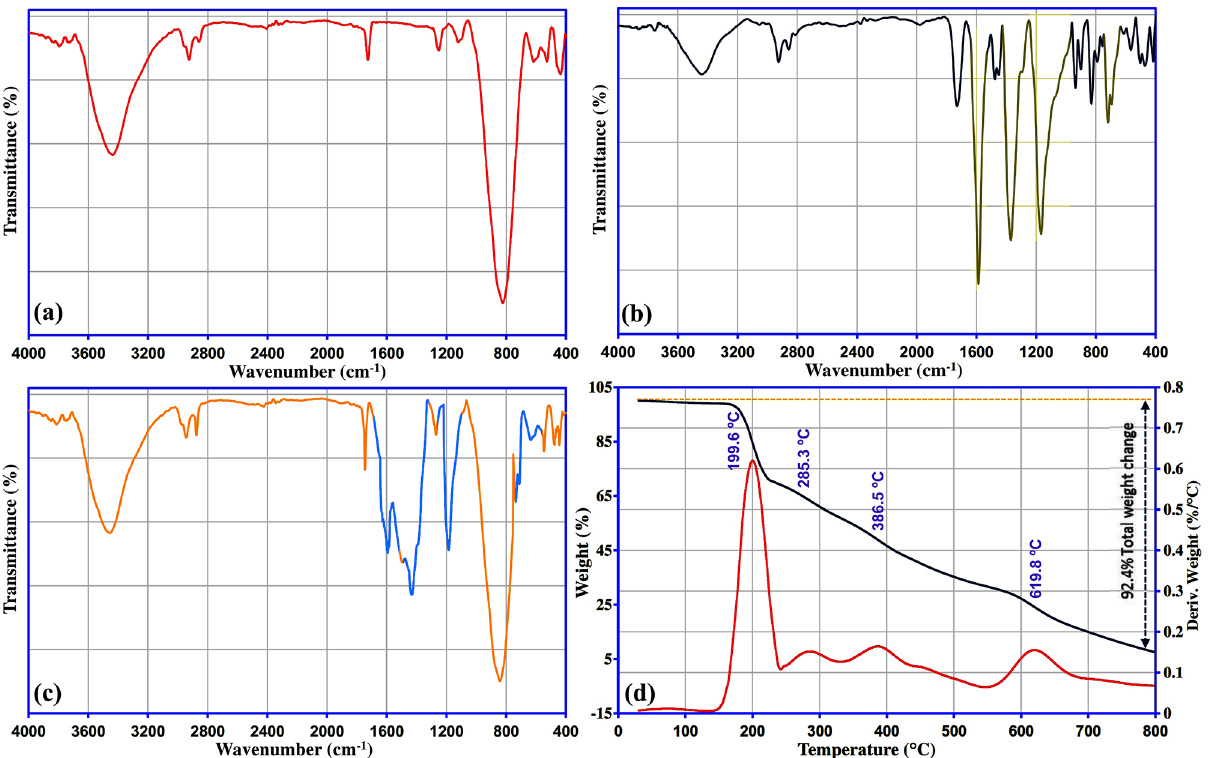
Figure 9. FT-IR spectra of ( a ) meso-CaAl 2 O 4 before adsorption of MG dye, ( b ) MG dye, ( c ) meso-CaAl 2 O 4 after adsorption of MG dye, and ( d ) TGA/DTG curves of MG